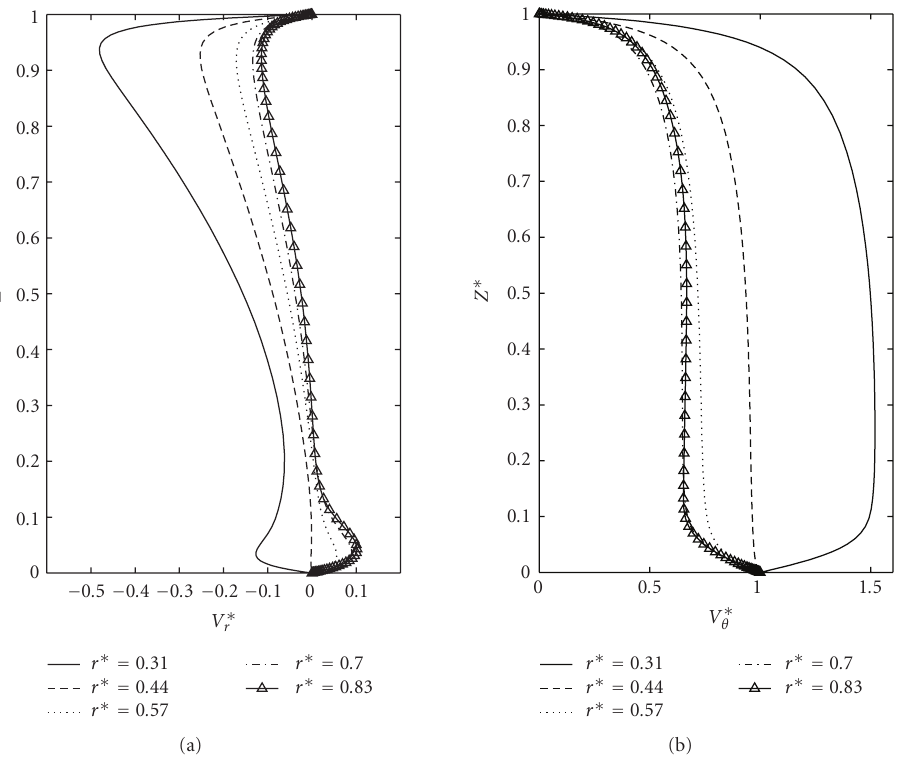
Figure 22: Axial profiles of the mean radial and tangential velocity components for Re = 10 6 , G = 0 . 02, and C w = 2500 at di ff erent radial locations r ∗